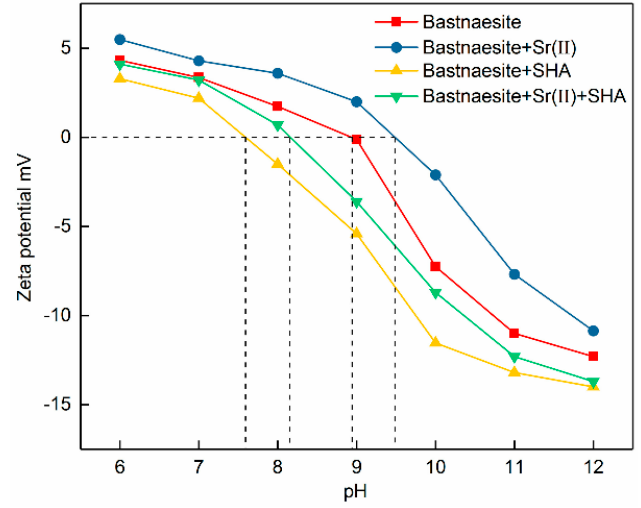
Figure 3. Zeta potential of bastnaesite treated and not treated with strontium ions as a function of pH in the absence and presence of SHA.